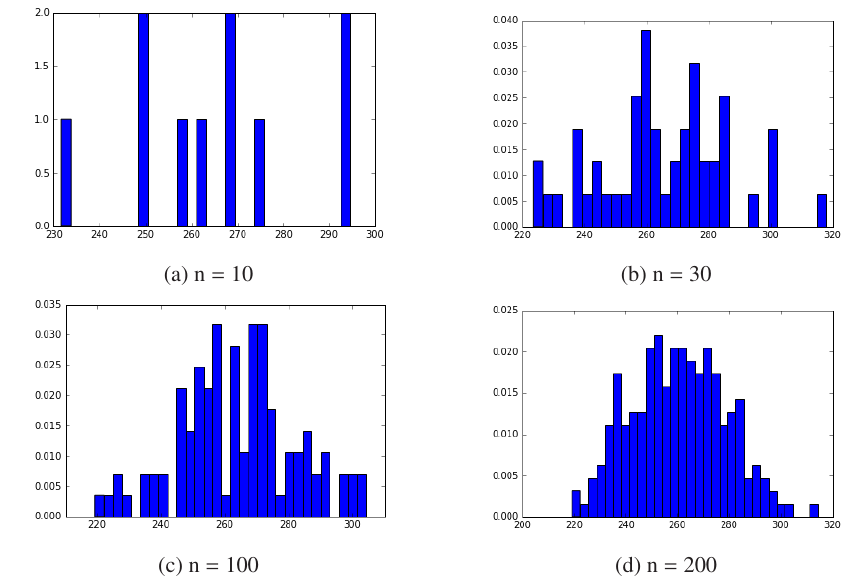
Figure 5: Histogram for Monte Carlo simulations with di ff erent number of samples